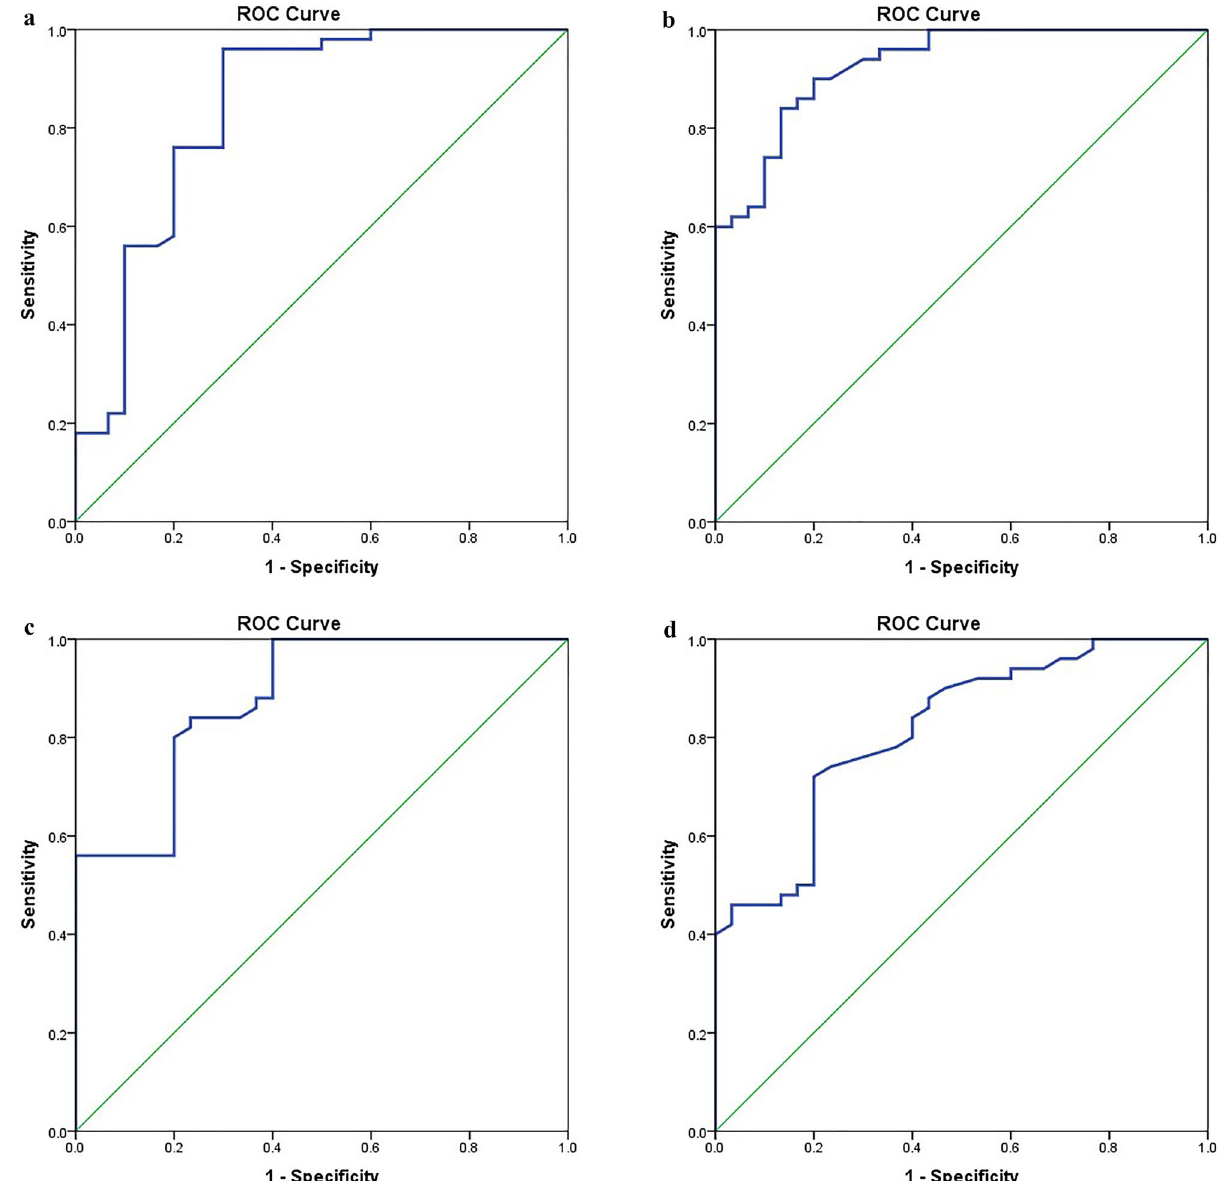
Figure 3. ( a ) ROC curve analysis for serum level of IL-10 in patients versus controls. IL-10 increased in patients compared to controls with good discriminating efficiency with AUC = (0.84±0.05 p = 0.0001*). SPSS software version 22 was used. ( b ) ROC curve analysis for serum level of TNF-α in patients versus controls. TNF-α increased in patients compared to controls with good discriminating efficiency with AUC = (0.92±0.02 p = 0.0001*). SPSS software version 22 was used. ( c ) ROC curve analysis for serum level of INF- γ in patients versus controls. INF- γ increased in patients compared to controls with good discriminating efficiency with AUC = (0.88±0.03 p = 0.0001*). SPSS software version 22 was used. ( d ) ROC curve analysis for serum level of TLR-4 in patients versus controls. TLR-4 increased in patients compared to controls with good discriminating efficiency with AUC = (0.81±0.04 p = 0.0001*). SPSS software version 22 was